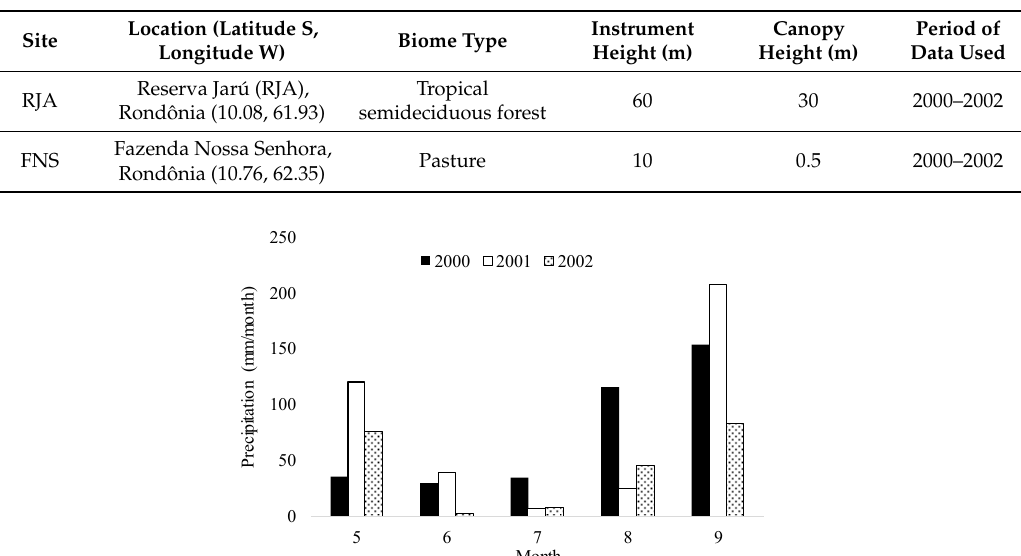
Figure 2. Monthly average precipitation over the dry season at RJA in Rondônia.